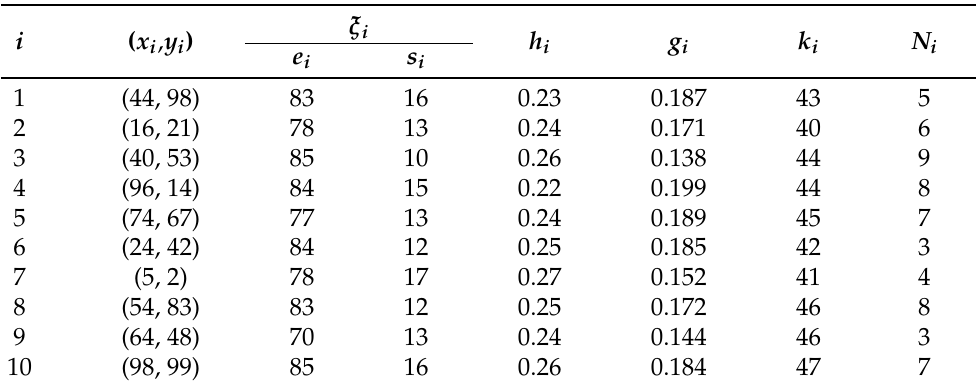
Table 2. Specified parameters for the supply chain.